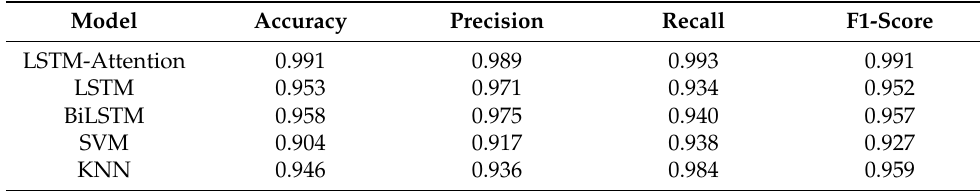
Table 7. Classification results of different models on the dataset.